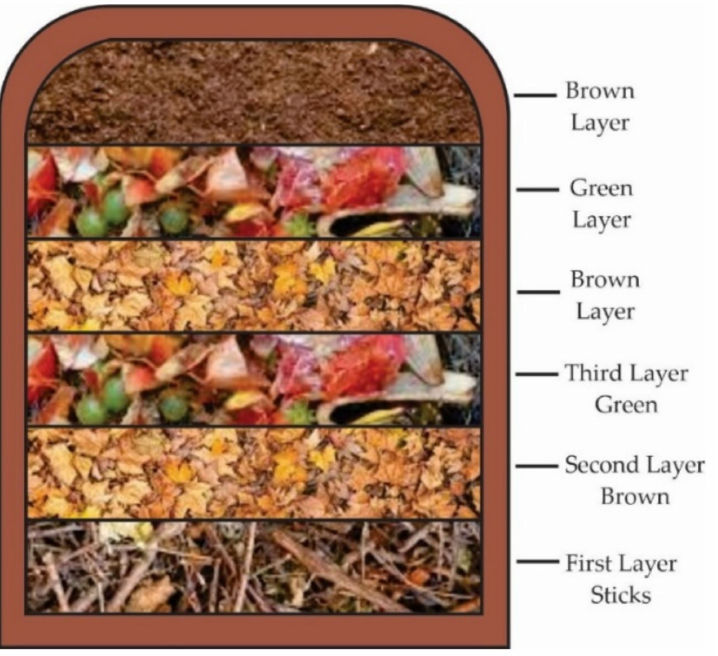
Figure 11. The layering of the compost